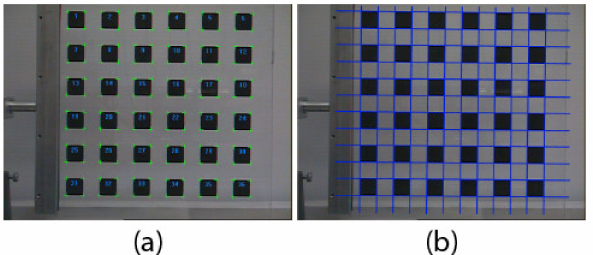
Figure 5. Calibration target composed of a 6 × 6 grid of black squares printed on a transparent glass plate. The side of each square is 2 cm long. The space between the columns and lines in the grid is 2 cm. ( a ) Final result of the detection of the corners of the squares for the first iteration. ( b ) Line fitting for iterations following iteration